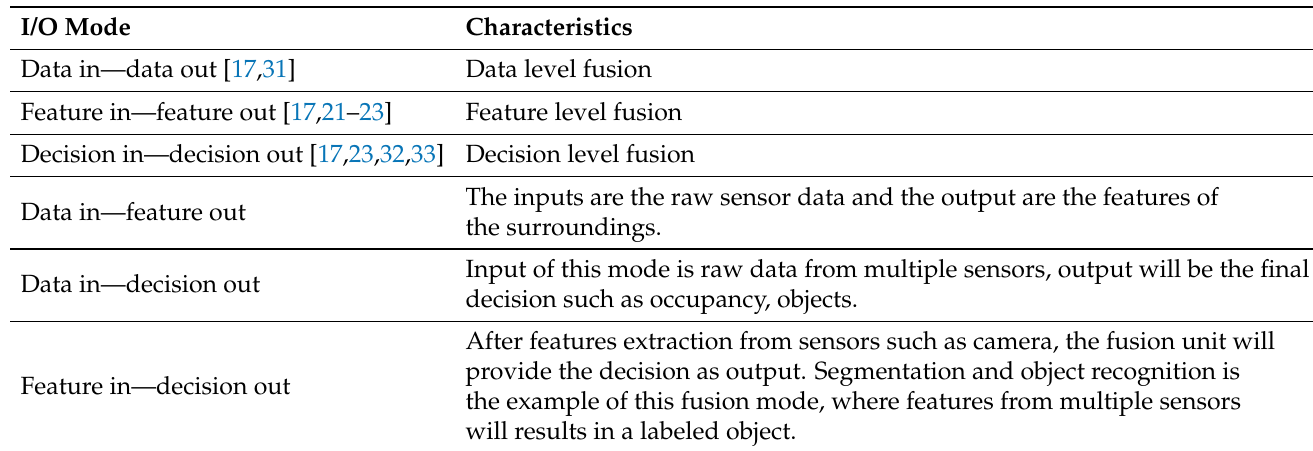
Table 2. The six I/O modes for fusion process